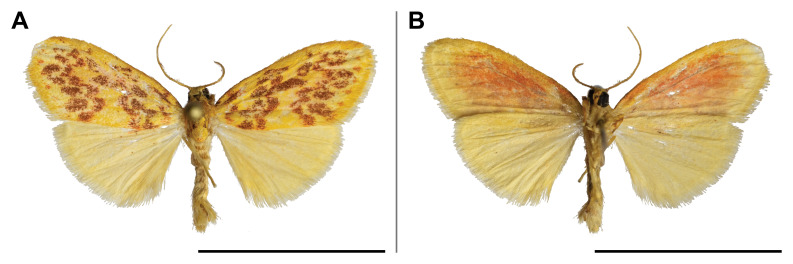
Palaeugoa
spurrelli (Hampson, 1914). A. dorsal view; B. ventral view. The scale bar represents 1 cm.